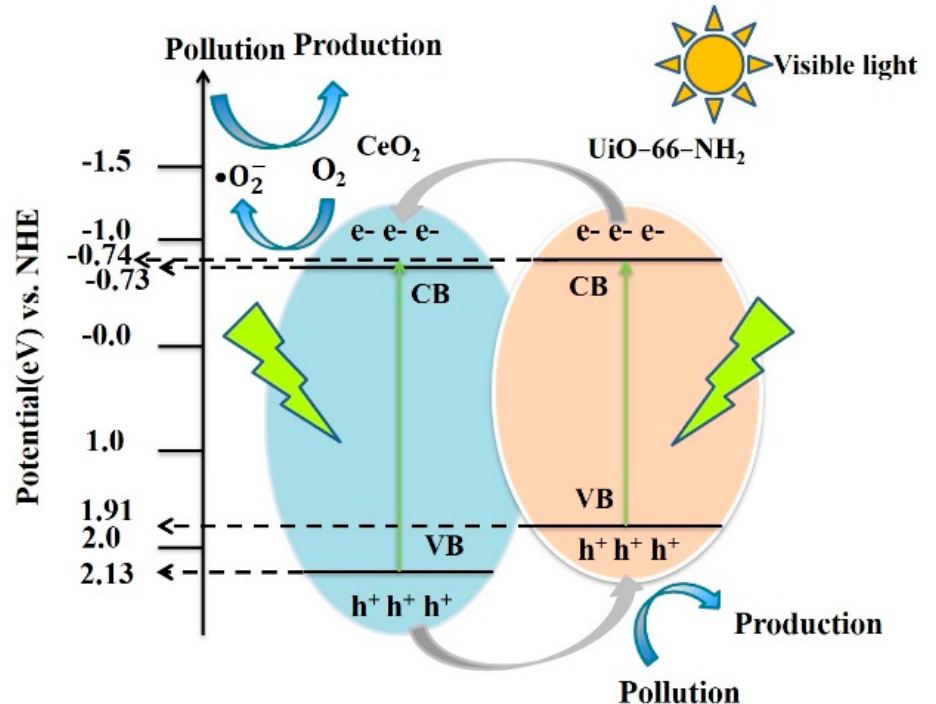
Figure 17. Photocatalytic mechanism of a Ce/UN composite.